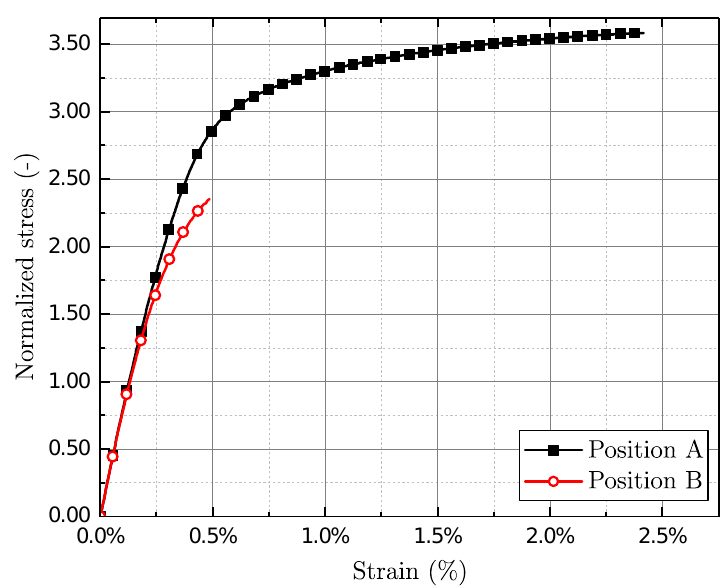
Figure 7. Representative tensile tests for positions A and B.